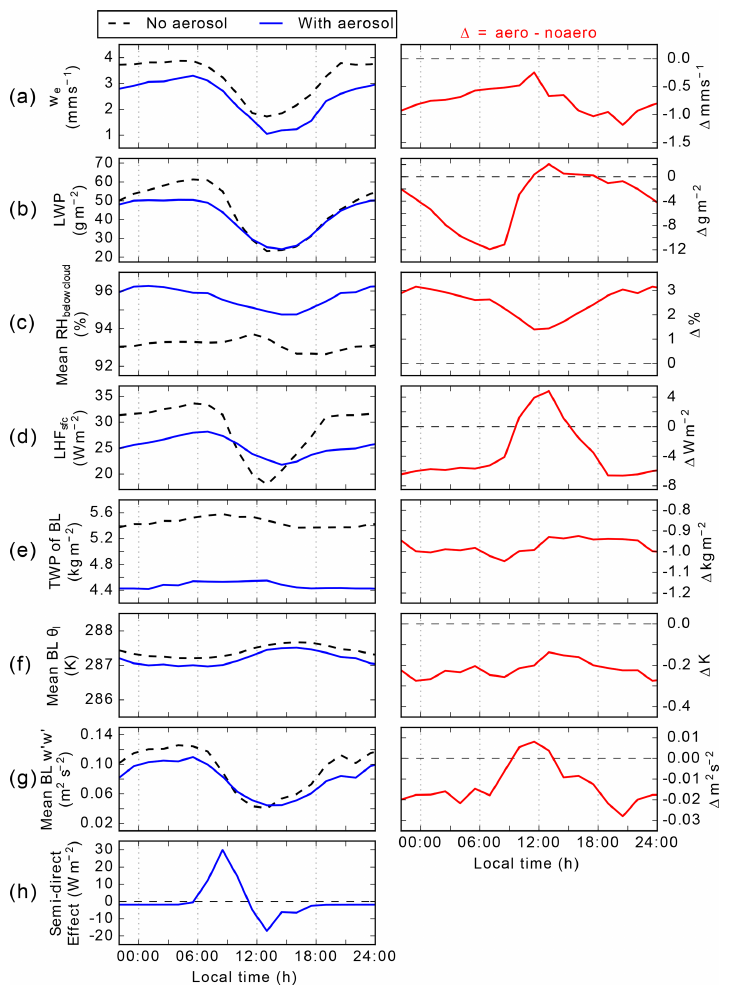
Figure 6. Domain-averaged cloud response to a layer of absorbing aerosol directly above the inversion in the base experiment (0m cloud– aerosol gap, 250m thick layer, and AOD of 0.2) for the mean diurnal cycle using the final 3d of the 15d simulation. In the first column the black dashed lines refer to the control experiment (no-aerosol) and solid blue lines to the experiments with the aerosol layer present. The second column shows the cloud response (red solid line). The plots show (a) the entrainment rate w e , (b) the liquid water path (LWP), (c) the mean relative humidity (RH) between the ocean surface and cloud base, (d) the latent heat flux (LHF) from the surface, (e) the total water path (TWP) of the boundary layer (BL), (f) the mean liquid water potential temperature ( θ l ) of the BL, (g) the mean BL vertical velocity variance ( w (cid:48) w (cid:48) ), and (h) the semi-direct